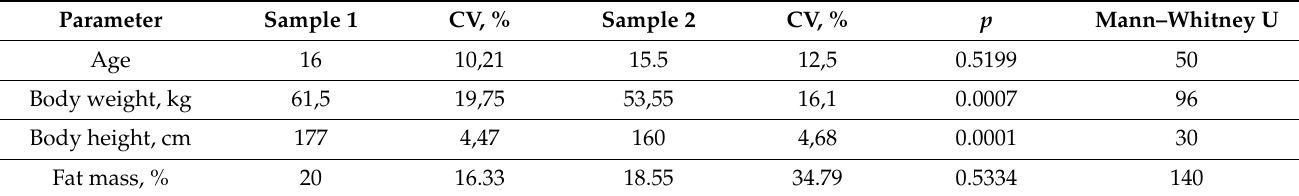
Table 1. Descriptive analysis regarding the study group.